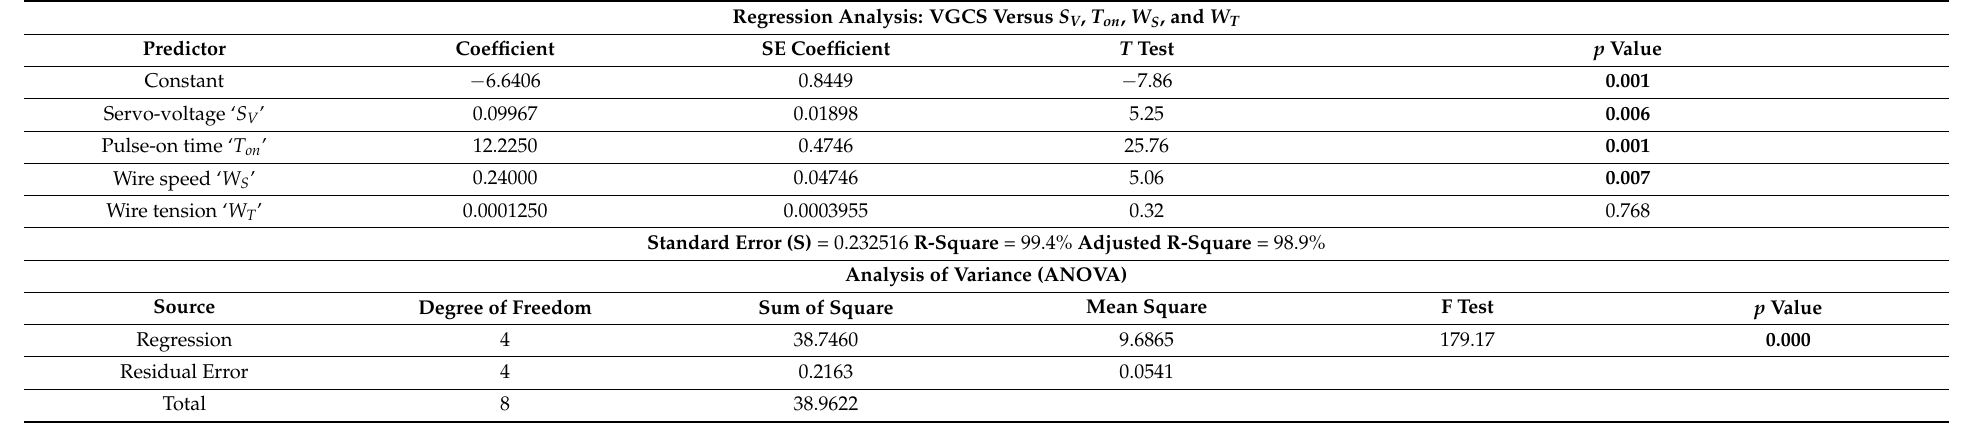
Table A2. Results of regression analysis and ANOVA for all responses considered in this work. Regression Analysis: VGCS Versus S V , T on , W S , and W